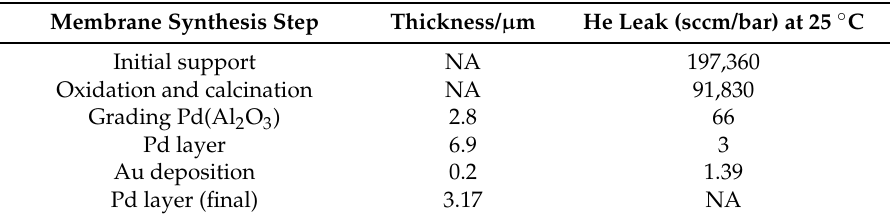
Table 2. Characteristics of the membrane at different phases of the synthesis.